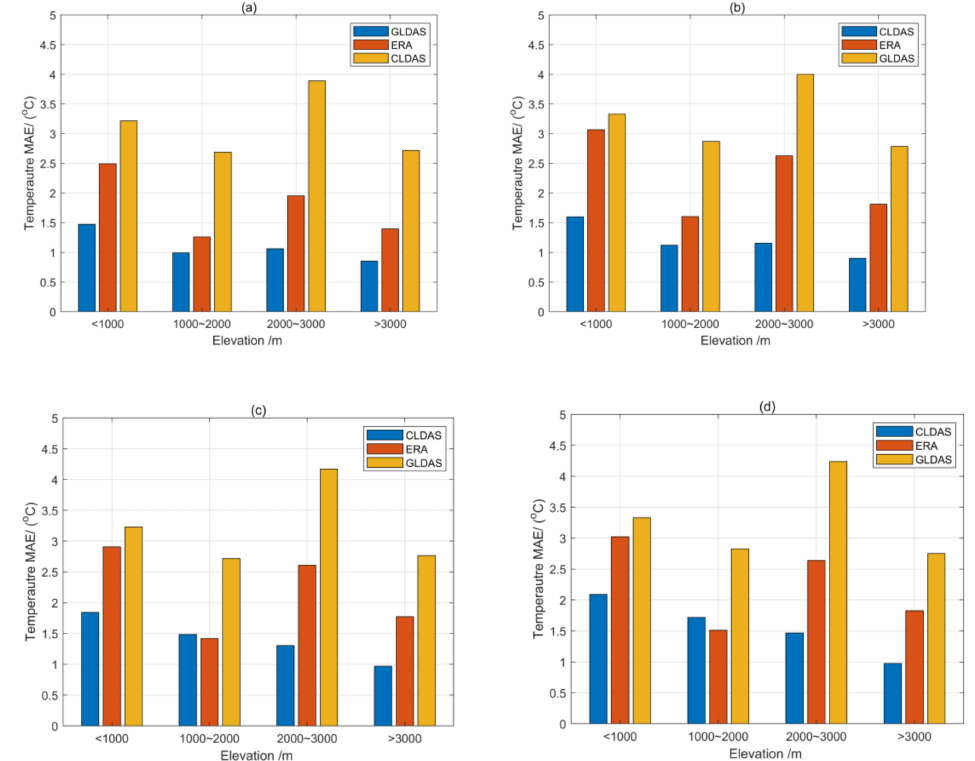
Figure 7. MAE of ST10 ( a ), ST20 ( b ), ST40 ( c ), and ST80 ( d ) in different elevation.